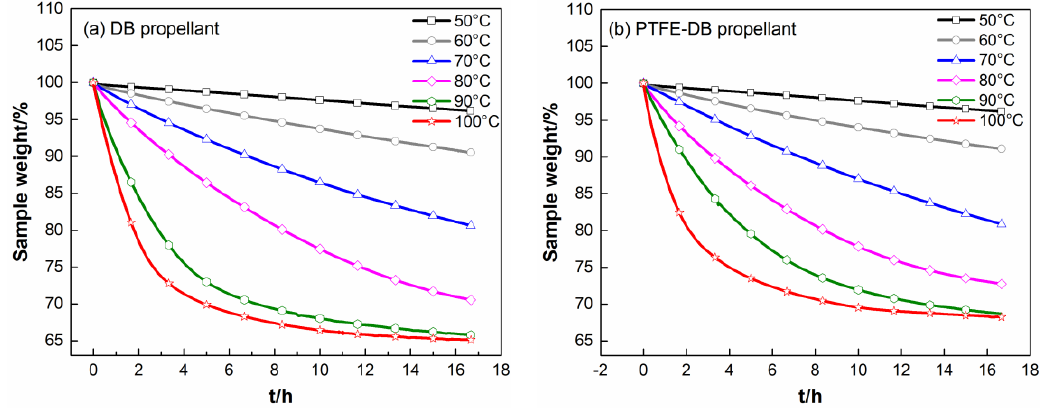
Figure 4. Isothermal TG curves of DB propellant ( a ) and PTFE-DB propellant ( b ) at different temperatures.